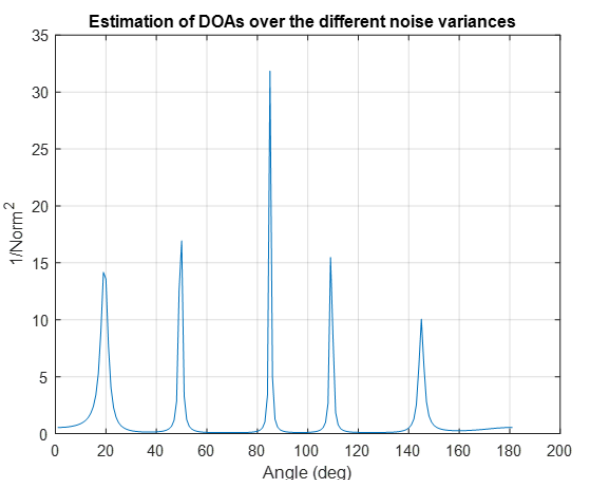
Figure 1. DOA Estimation for SNR = 0 db, Snapshot Number = 100, P = 5 and DOA = [20°; 50°; 85°; 110°; 145°] (different noise variances).